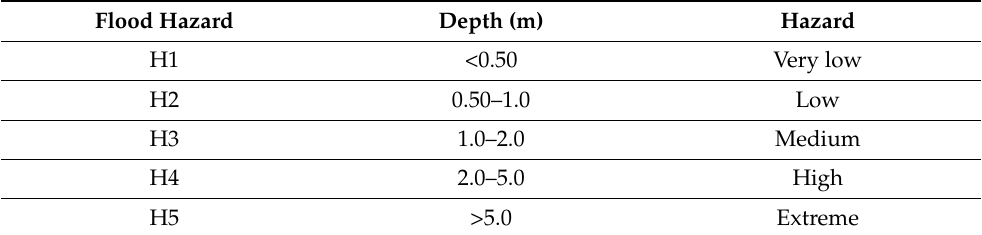
Table 5. Flood hazard classification criteria of the Ministry of Land Infrastructure and Transport (MLIT), Japan.